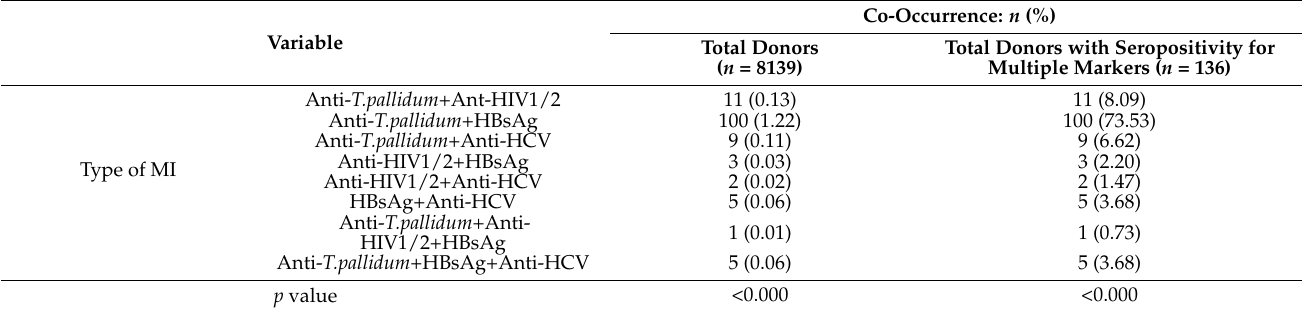
Table 4. Co-occurrence of the serologic markers of multiple